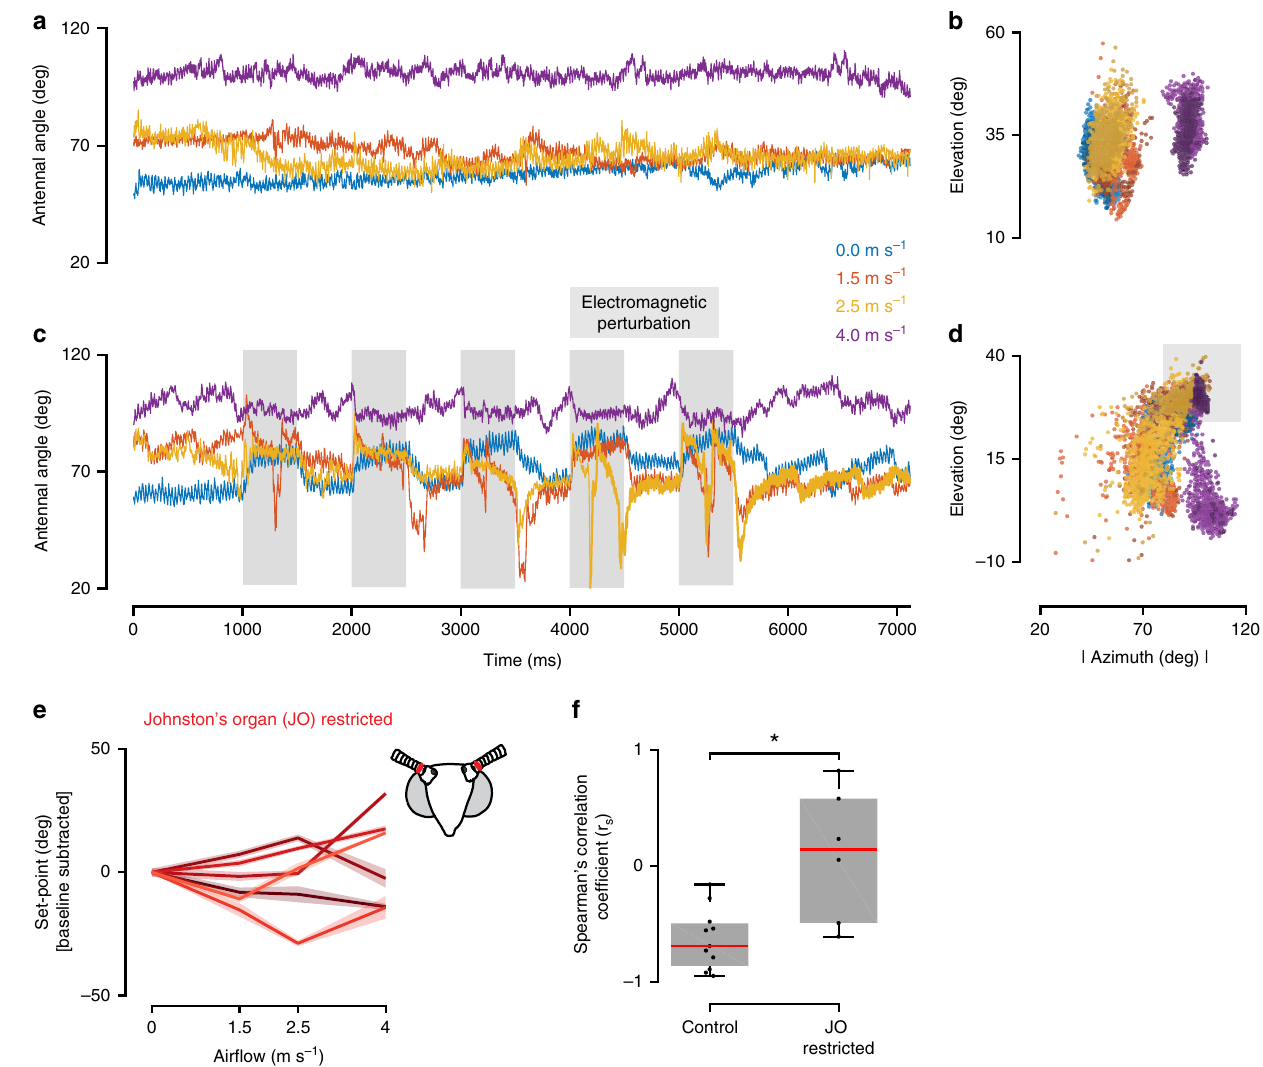
Fig. 3 Electromagnetic perturbation of antennal position in JO-restricted moths. a – d Representative raw data plots of antennal response to perturbations in JO-restricted moths. a The right antenna (internal control) was unaffected by the perturbations of the left antenna, same as in control. b Azimuth-elevation plots show the clustering of right antennal position based on air fl ow. The clusters for 0, 1.5 and 2.5 m s − 1 were identical. At higher air fl ows (4 m s − 1 , purple trace) the antenna was unable to maintain the same position and drifted slightly backward. c The perturbed antenna was actively corrected in JO-restricted moths. They, however, were corrected to the same position regardless of air fl ow (except for 4 m s − 1 ). The sudden spikes in between were caused by the movement of the antenna by the ipsilateral front leg. d Three distinct antennal position clusters were observed — two based on air fl ow (0, 1.5 and 2.5 m s − 1 form one cluster and 4 m s − 1 forms the other one); the third is the perturbed location. e Antennal set-points of JO-restricted moths . JO-restricted moths also correct their antennae, but the corrected position (set-point) remains constant regardless of the frontal air fl ow. Different shades indicate different individuals ( n = 6 individuals). The overlay around each line indicates the standard error of the mean (s.e.m). f Statistical analysis. Box-and-Whisker plots of Spearman ’ s correlation coef fi cient ( r s ) of set-points vs. air fl ow for two treatments (control: n = 11 trials, 9 moths, JO: n = 6 trials, 6 moths). Change in set-point in response to air fl ow was signi fi cantly different between control and JO-restricted moths (asterisks represent statistical difference, Wilcoxon rank sum test, p < 0.01; median values — Control: − 0.69, JO: